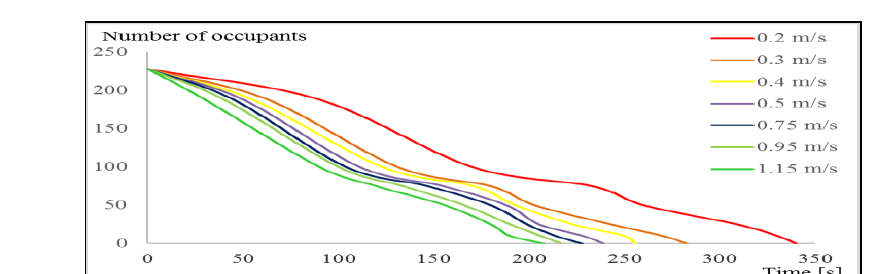
Figure 22 – Simulation results for the fastest times of the seventh case of the second